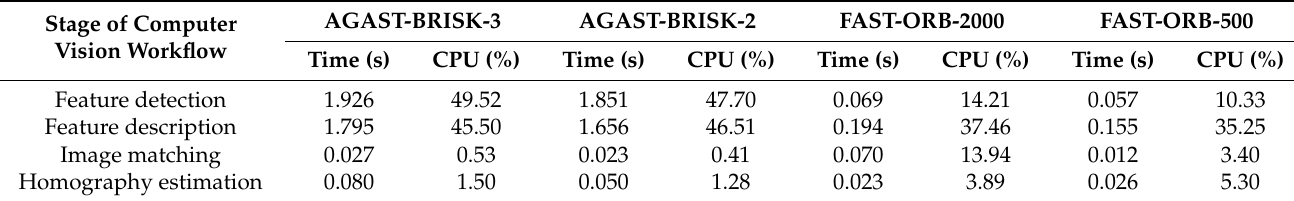
Table 7. Average computational time and percentage of CPU usage in the total computer vision workflow recorded for the four basic steps of image matching for each experiment performed via the ModAR prototype using the low-end device. Stage of Computer Vision Workflow Feature detection Feature description Image matching Homography estimation Table 8. Average computational time and percentage of CPU usage in the total computer vision workflow recorded for the four basic steps of image matching for each experiment performed via the ModAR prototype using the mid-range device. Stage of Computer Vision Workflow Feature detection Image